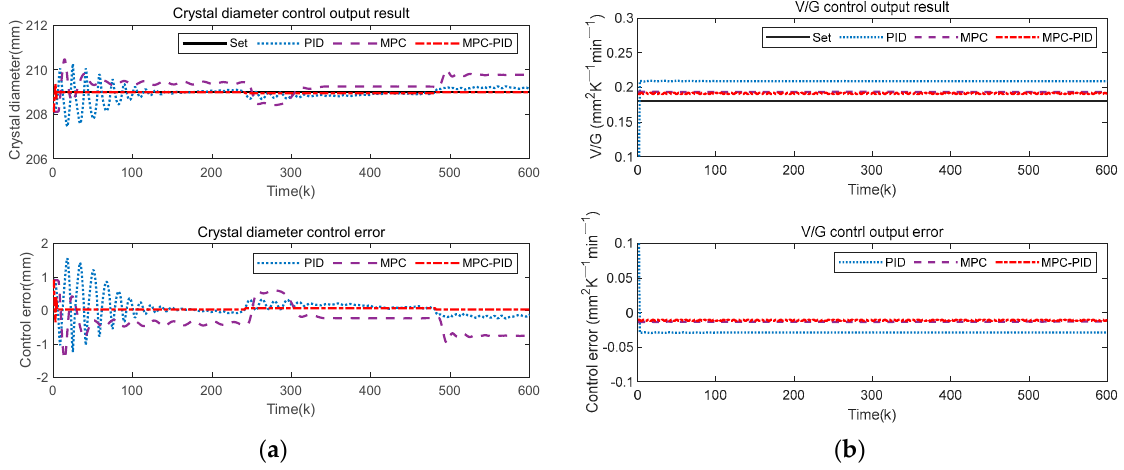
Figure 13. Control results of different control methods under square wave noise disturbance: ( a ) crystal diameter control output results; ( b ) V/G control output results.